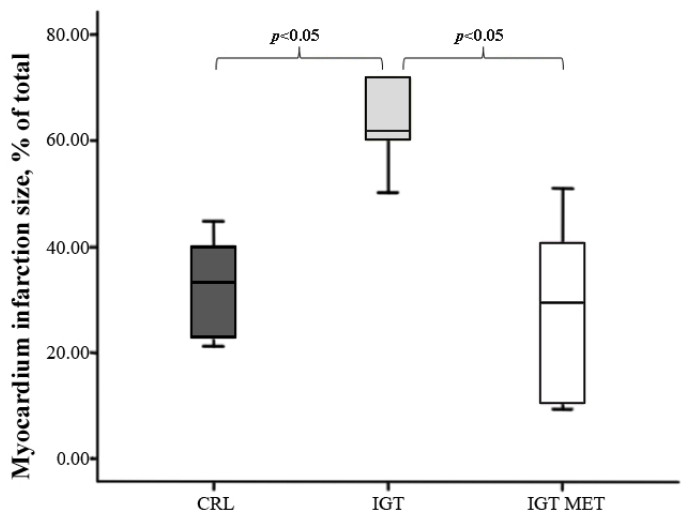
Figure 3. Myocardial infarction size in isolated rat hearts subjected to 30 min of global ischemia followed by 90 min of reperfusion. Notes: Results are presented as median (25%; 75%). CRL—con- trol group, IGT—impaired glucose tolerance group, IGT MET—impaired glucose tolerance + met- formin